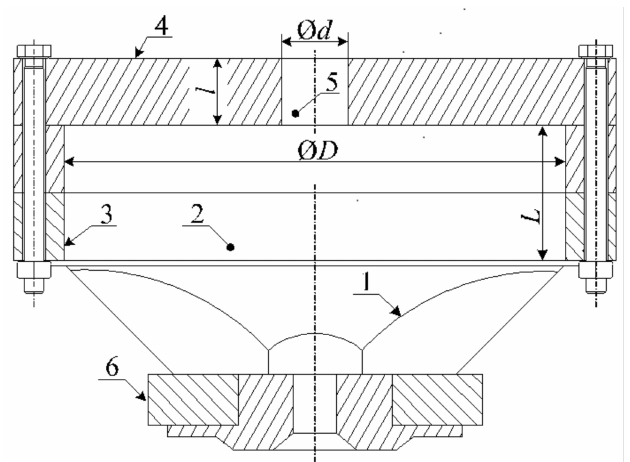
Figure 1. Schematic diagram of the investigated synthetic jet actuator: 1—diaphragm, 2—cavity, 3—spacer plate, 4—front plate with orifice, 5—orifice, 6—loudspeaker.